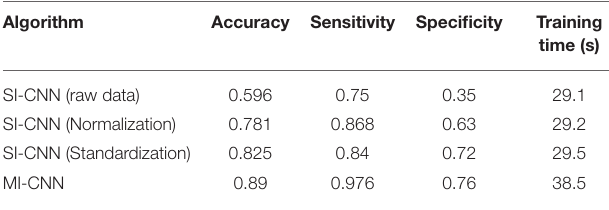
TABLE 3 | Results of neural networks with different data preprocessing methods on the running dataset.